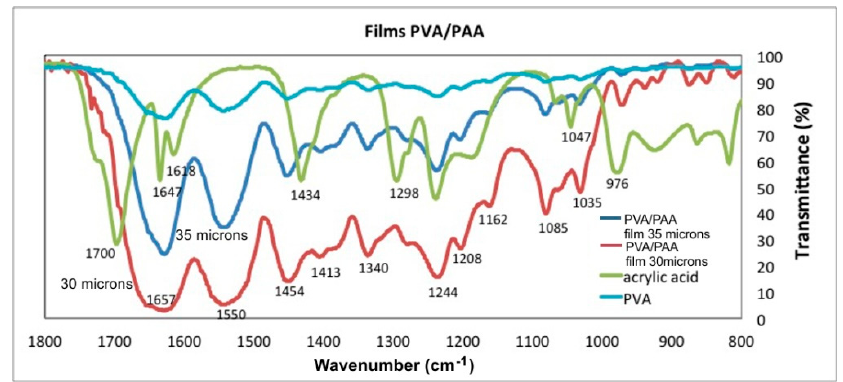
Figure 10. Transmittance as a function of wavenumber for PVA, PAA, and two PVA/PAA films.